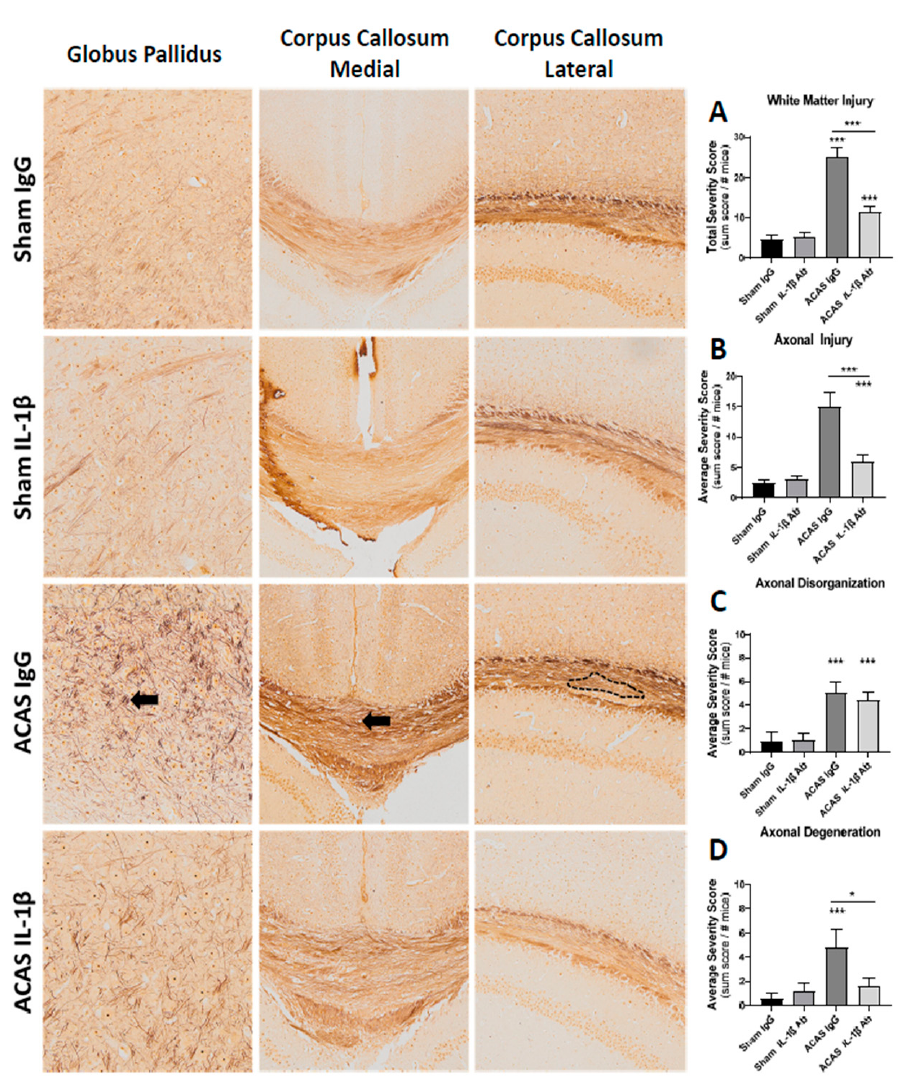
Figure 4. White matter pathology at 42 days after ACAS or sham surgery and the initiation of IL-1 β antibody or IgG treatment. Depicted are the four treatment groups: sham = IgG, Sham + IL-1 β Ab, ACAS = IgG and ACAS + IL-1 β Ab for the following brain regions: globus pallidus and corpus callosum. The arrow in the ACAS IgG globus pallidus slide shows disorganized axons; the arrow in the ACAS IgG corpus callosum medial slide shows axonal loss; and the dashed line in the ACAS IgG corpus callosum lateral slide shows axonal disorganization. Bar graphs shown in ( A – D ) are mean ± SEM for lesion severity scores for each of the four treatment groups: n = 9 mice/group; * p < 0.05 between the connected groups; *** p < 0.001 vs. sham + IgG group or the ACAS + IL1- β Ab group.